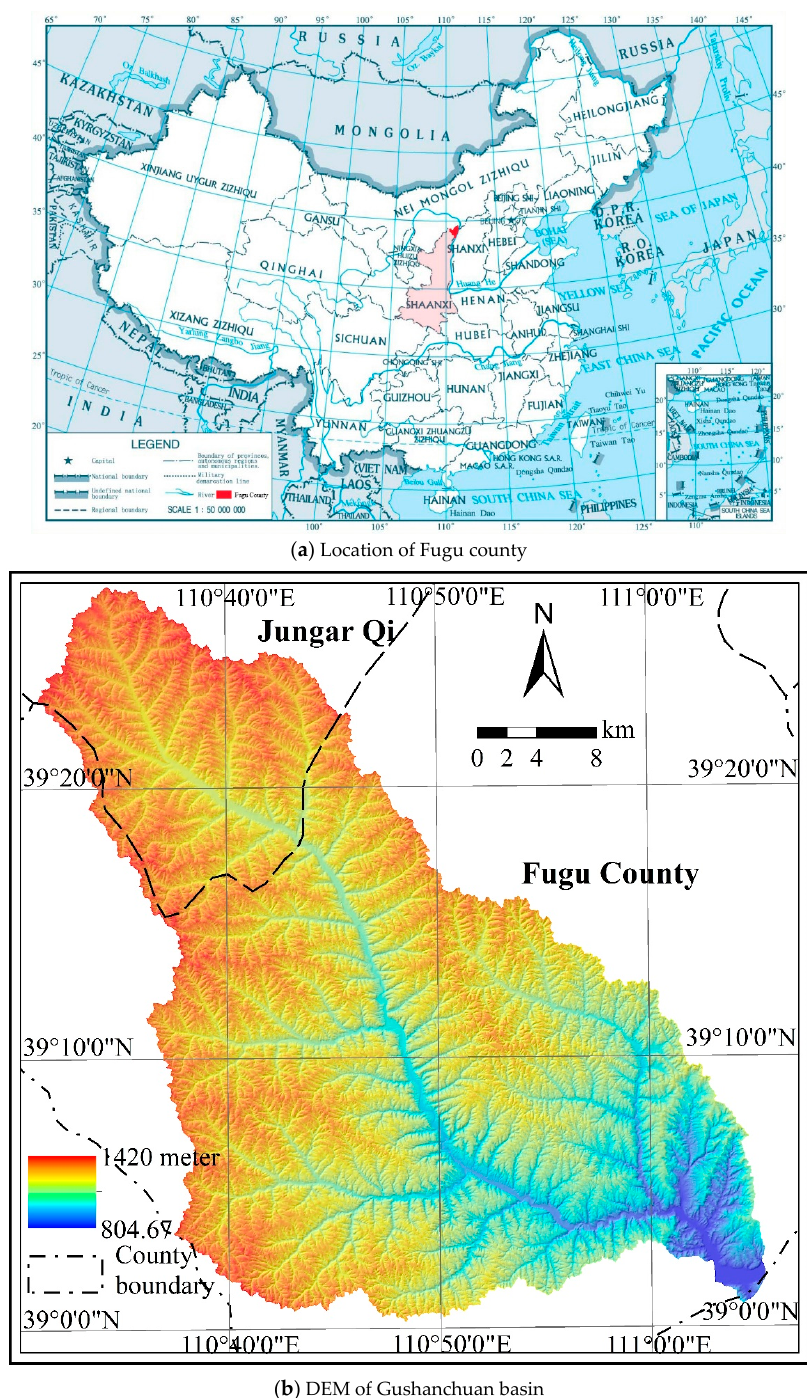
Figure 11. Location and digital elevation model (DEM) of Gushanchuan basin.